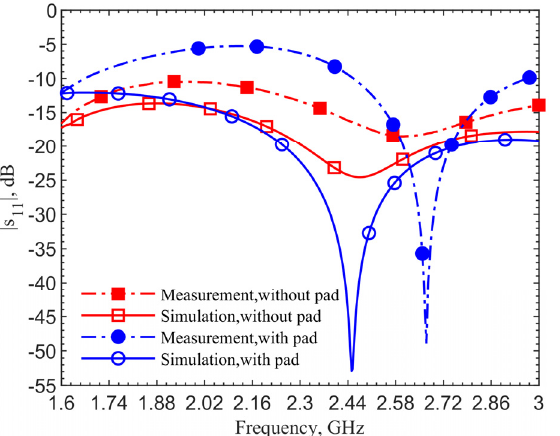
Figure 5. Simulation and measurement results of the coupler with and without the center pad for the 2.4–2.5 GHz designs.